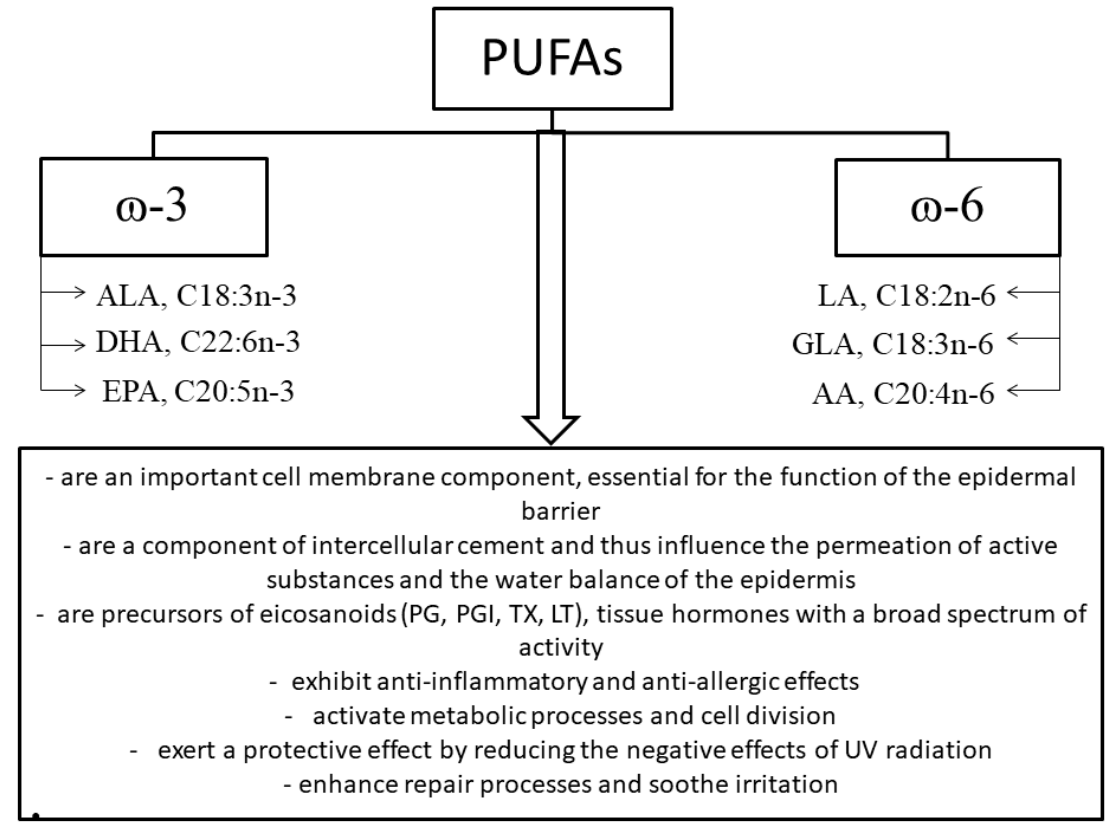
Figure 5. Classification of polyunsaturated fatty acids and the effects of omega-3 and omega-6 fatty acids on physiological processes in the skin; ALA, alpha-linolenic acid; DHA, docosahexaenoic acid; EPA, eicosapentaenoic acid; LA, linoleic acid; GLA, gamma-linolenic acid; AA, arachidonic acid; PG, prostaglandins; PGI, prostacyclins; TXA, thromboxanes; LT, leukotrienes (own work based on [151,153,154]).